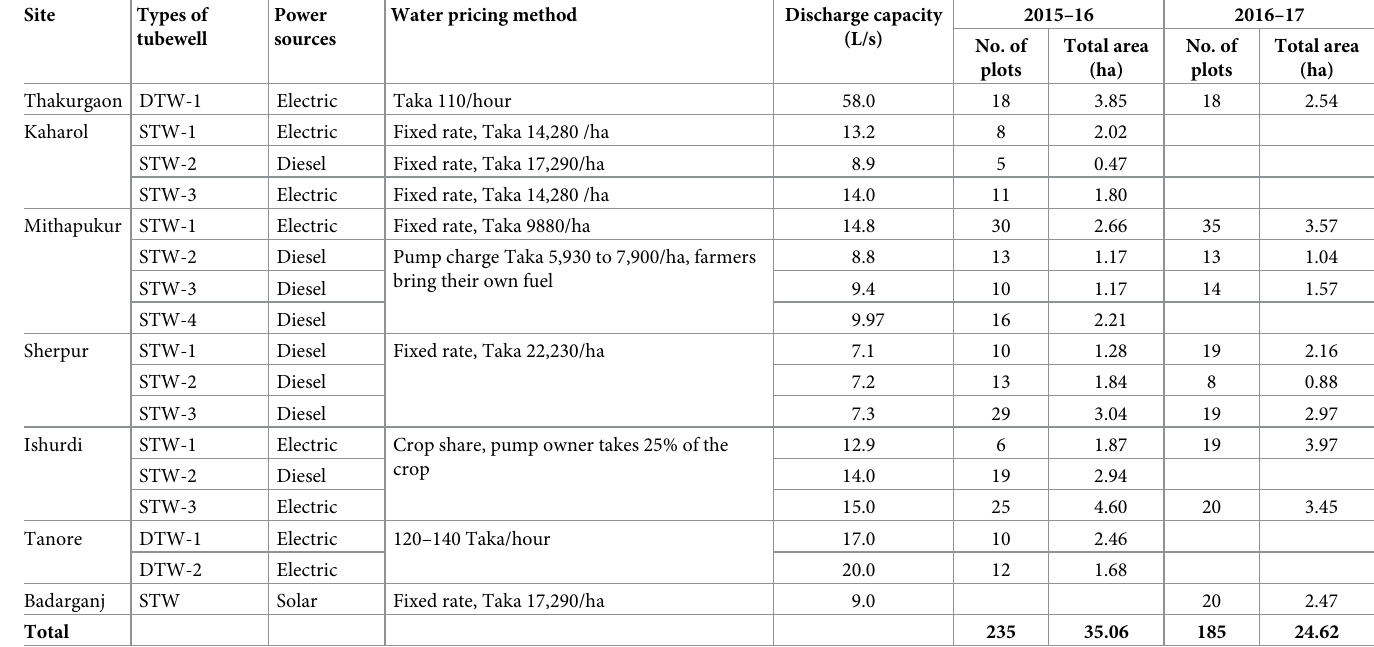
Table 1. Summary information of the tubewells in the selected sites during Boro rice growing season (November to May) of 2015–16 and